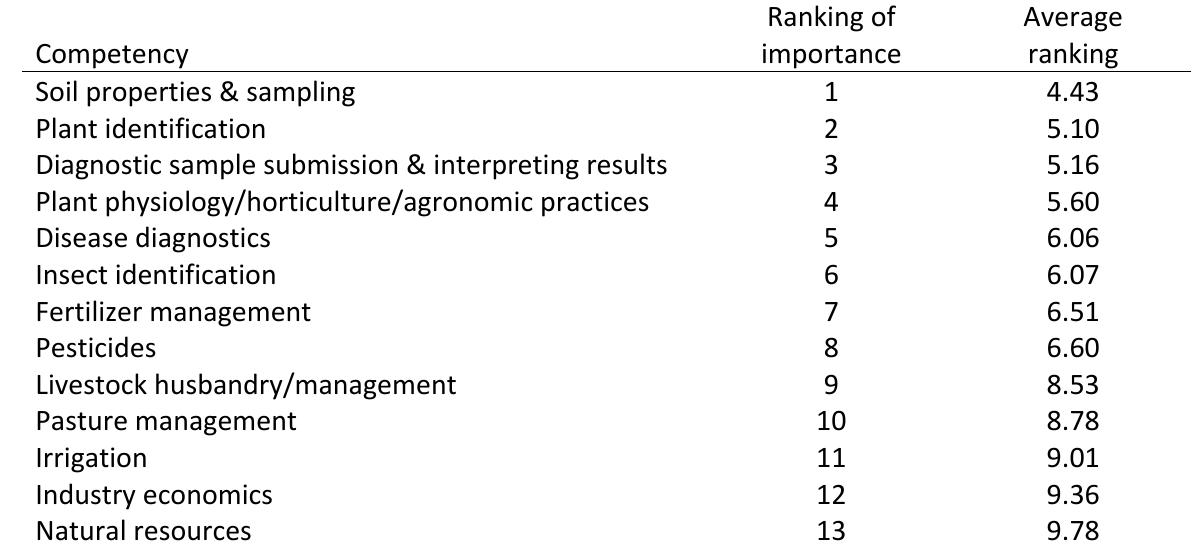
Ranking of Important Competencies from the Agriculture